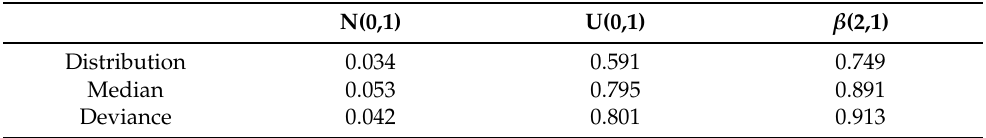
Table 1. Rate of rejection based on 1000 repetitions for three permutation tests: distribution, median and deviance from the median. The permutation tests for the median and deviation from the median are exact. The permutation test for the distribution is approximated, based on 1000 permutations. The first sample is based on the standard normal distribution, N(0,1), and the second on the N(0,1) (first column), the uniform in the (0,1) interval, U(0,1), (second column) and the beta with parameters (2,1), β (2,1), (third column). N(0,1) U(0,1) β (2,1) Distribution 0.034 0.591 0.749 Median 0.053 0.795 0.891 Deviance 0.042 0.801